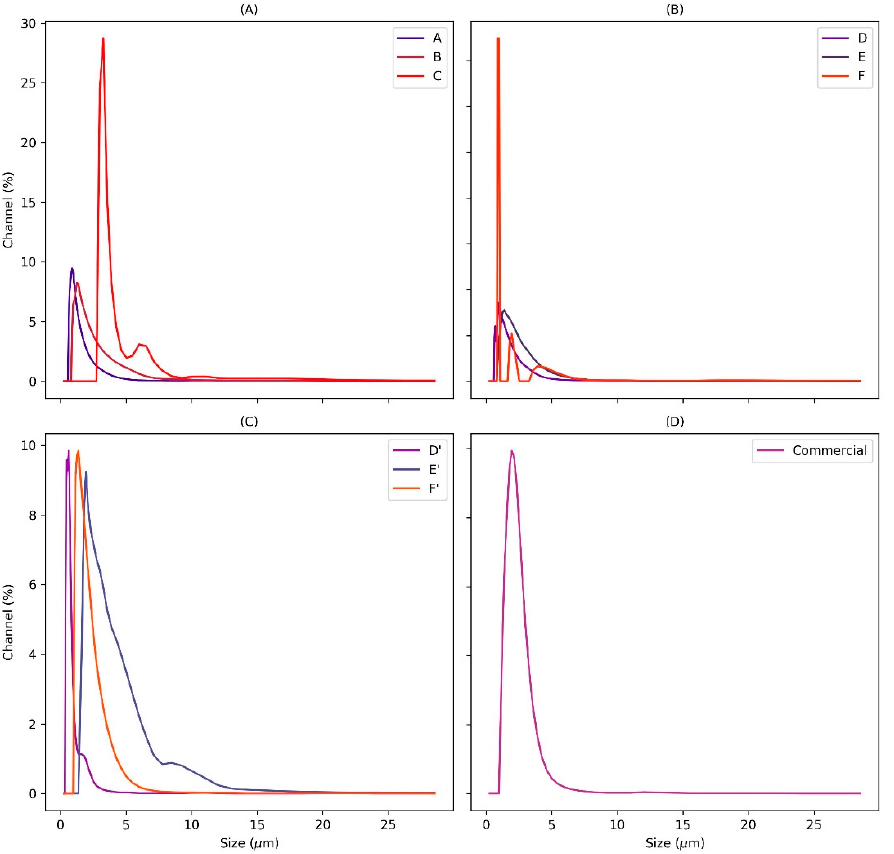
Figure 3. Particle size distribution of different mayonnaises. ( A ) Sodium alginate low-fat mayonnaises (A, B, C = 30, 22.5, 15% oil, respectively). ( B ) Low-fat mayonnaises with soy protein isolate (D, E, F = 30, 22.5, 15% oil, respectively). ( C ) Low-fat mayonnaises with spirulina protein concentrate (D’, E’, F’ = 30, 22.5, 15 oil%, respectively). ( D ) Commercial low-fat mayonnaise.